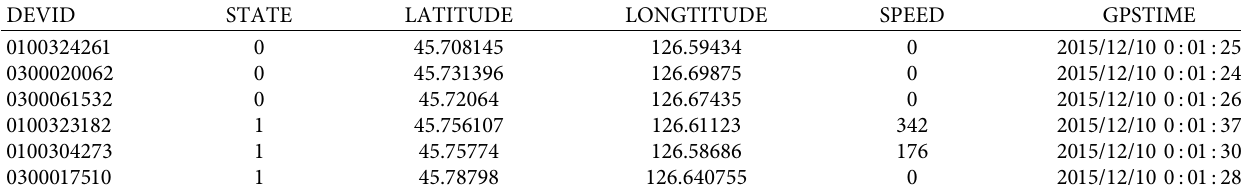
Figure 1: (a) Location of the study area and (b) the road network of the study area. Table 1: Taxi GPS data in Harbin